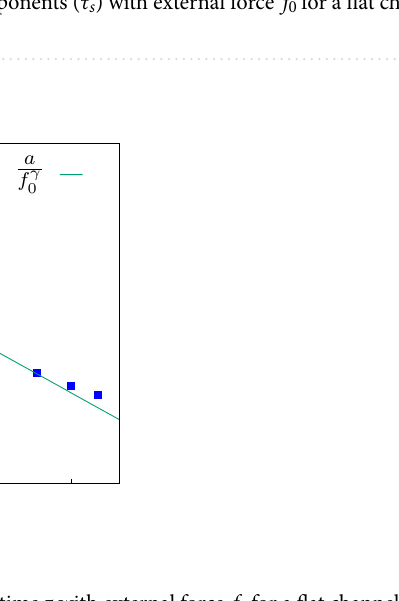
Figure 5. Variation of total translocation time τ with external force f 0 for a flat channel ( α = 0 ◦ ). τ ∼ 1 / f γ ≈ 1.78 .